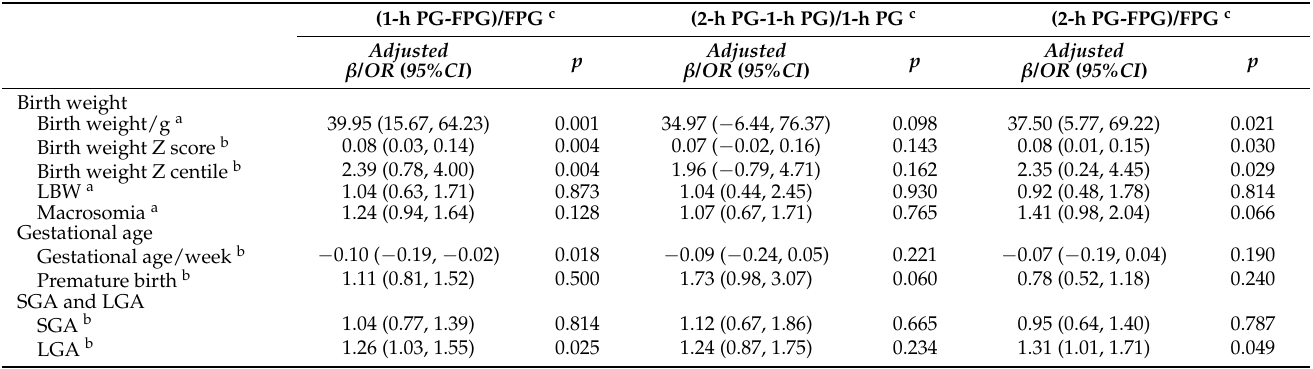
Table 5. Multivariate analysis of blood glucose change ratios during pregnancy and birth